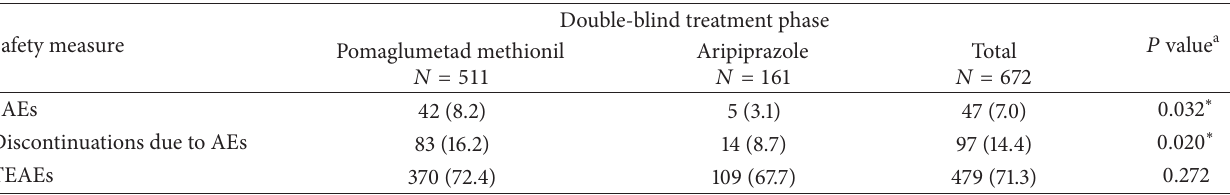
Table 2: Incidence of serious adverse events, discontinuations due to adverse events, and treatment-emergent adverse events during the double-blind treatment phase.